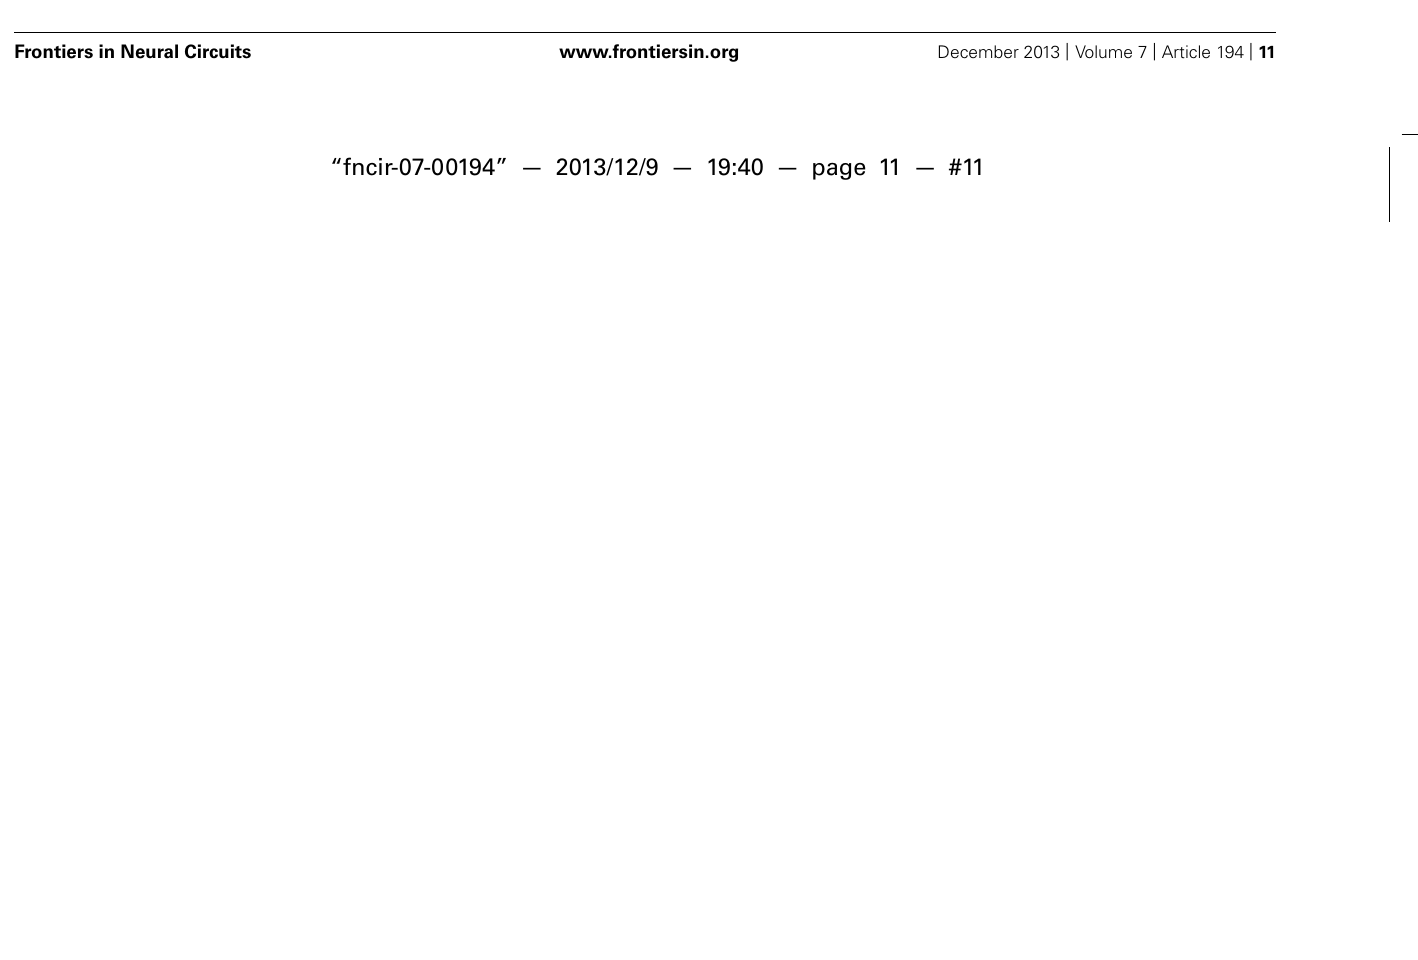
for zero delay at the intersection of the line y = 2 φ − 1 (gray line in Figure 6B1 ) with the PRC, but the right skew destabi- lizes the antiphase mode by causing it to fall on the destabilizing left branch, and the destabilization persists for short delays. The slope on the right branch at 1 − is not in the causal limit region, and is insufficiently steep to stabilize synchrony with zero